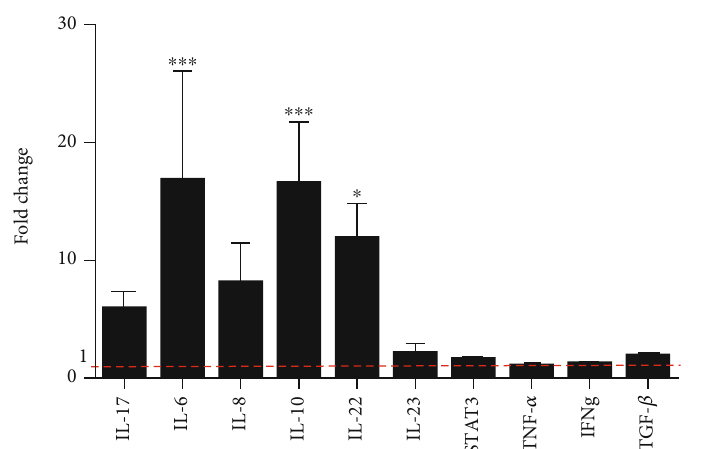
Figure 4: Gene expression of IL-17, IL-6, IL-8, IL-10, IL-22, IL-23, STAT3, TNF- α , and TGF- β in gastrospheres compare to parental cells. Data are mean ± SD of four independent experiments. ∗ P < 0 : 05 , ∗∗ P < 0 : 01 , and ∗∗∗ P < 0 : 001 .